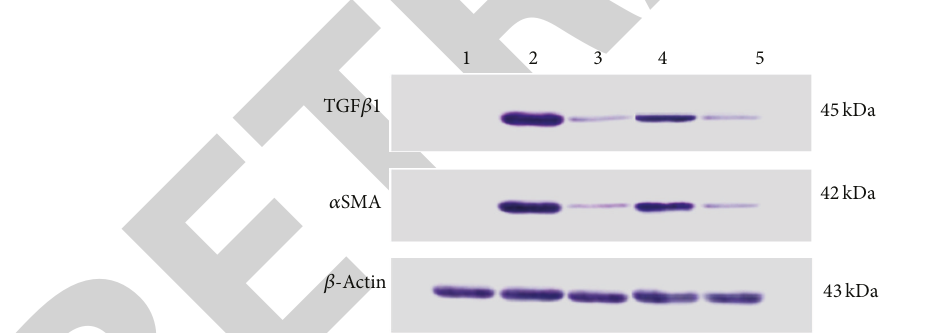
Figure 4: Western blot analysis of TGF- 𝛽 1 and 𝛼 SMA levels in liver tissue for all experimental groups. (1) Normal control group, (2) TAA group (hepatotoxic group), (3) SY + TAA group, (4) CS100 + TAA group, and (5) CS300 + TAA